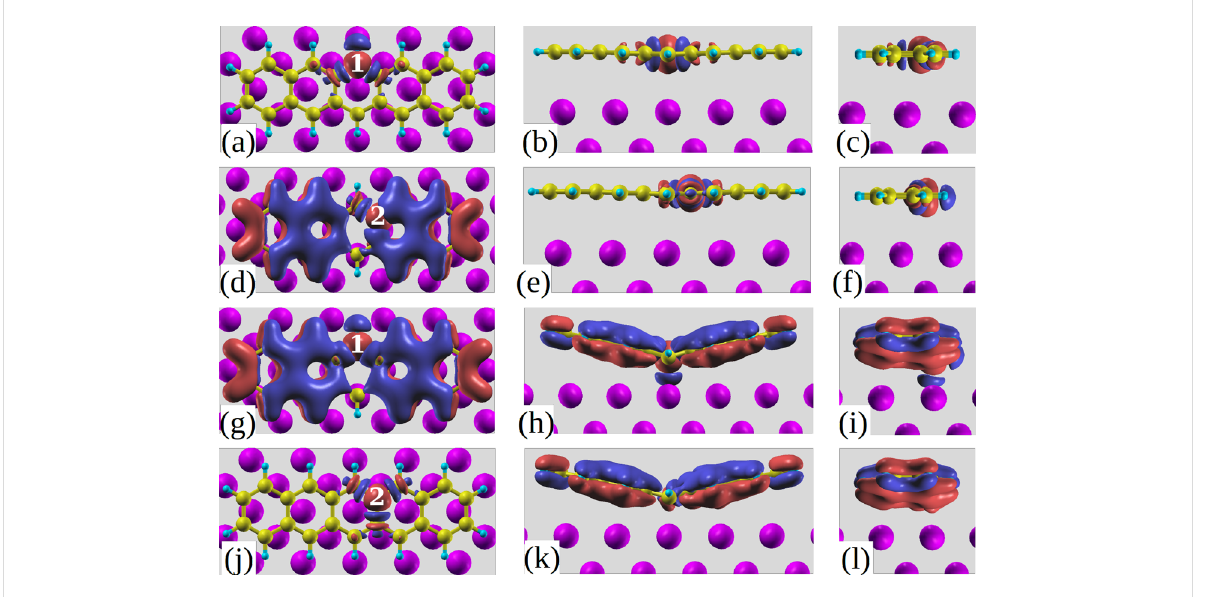
Figure 5: Top and side views of the screening charges in the presence of a full core hole on (a,b,c) C1 at the T site; (d,e,f) C2 at the T site; (g,h,i) C1 at the B site and (j,k,l) C2 at the B site for an isodensity value of 0.005 e /Bohr 3 .